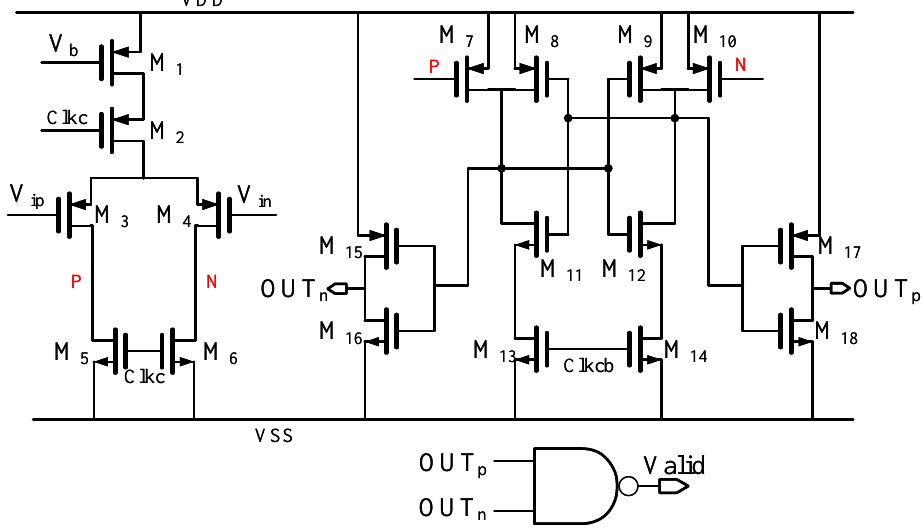
Figure 8. The proposed dynamic comparator